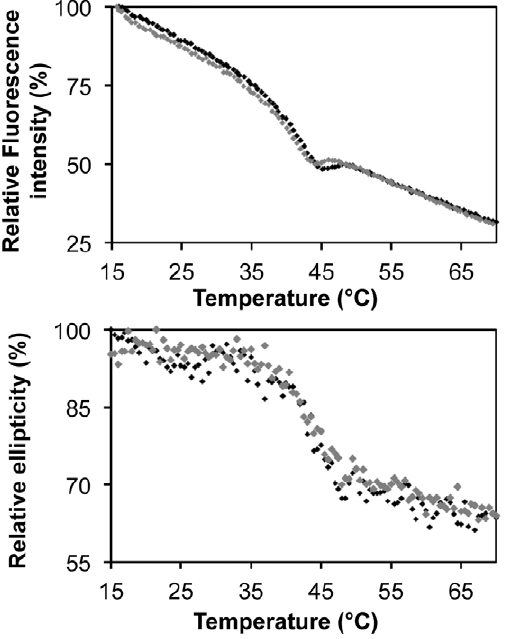
Figure 4. Effect of phosphorylation on stability of SERK1-KD against thermal unfolding. Top: Thermal unfolding monitored by the change in fluorescence emission at 340 nm, upon excitation at 280 nm. Bottom: Thermal unfolding monitored by the change in ellipticity at 210 nm. Data of native SERK1-KD are shown in black, and data of phosphorylated SERK1-KD are shown in